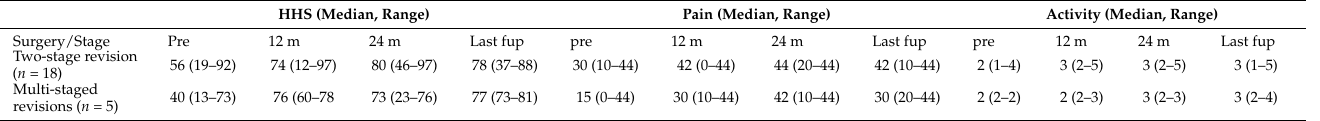
Table 6. Functional outcomes in patients undergoing two-stage or multi-staged revisions by time.